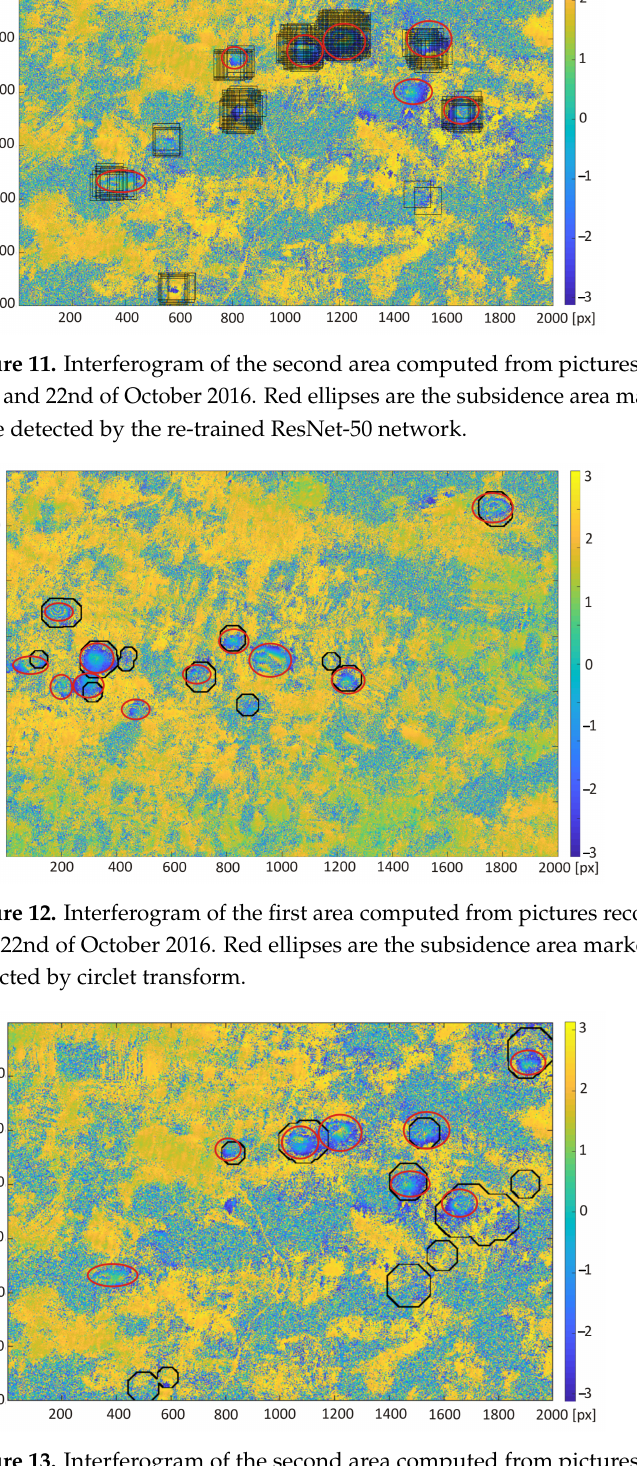
Figure 13. Interferogram of the second area computed from pictures recorded by Sentinel-1 on the 10th and 22nd of October 2016. Red ellipses are the subsidence area marked by experts; black lines were detected by circlet